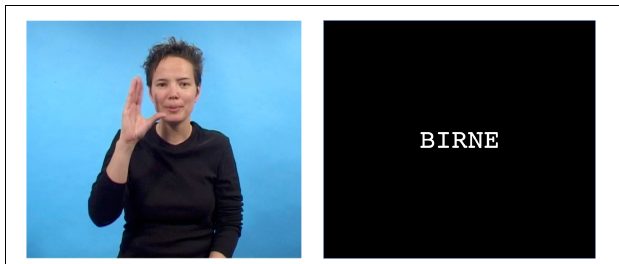
FIGURE 1 | Illustration of one trial in the overlapping sign fragment – written word condition: The sign fragment “ BI ” for BIRNE (pear) is followed by the overlapping written word Birne